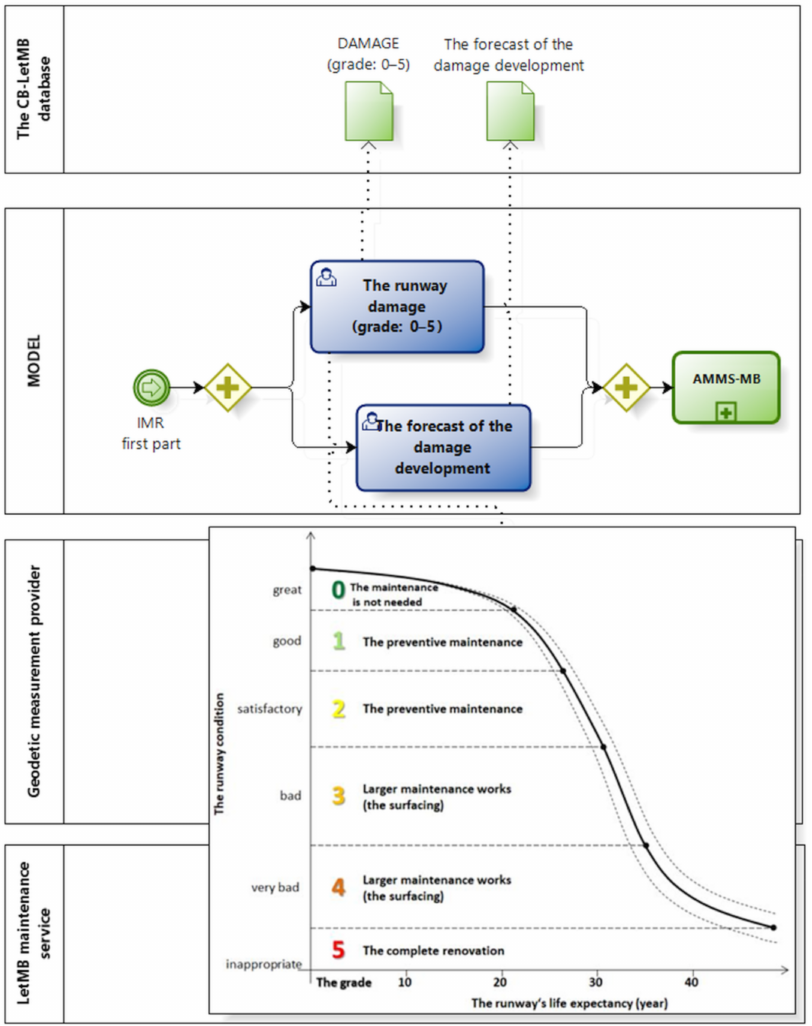
Figure 7. Second part of the BPD’s process decision-making maintenance model IMR, with the level of runway condition (the level of